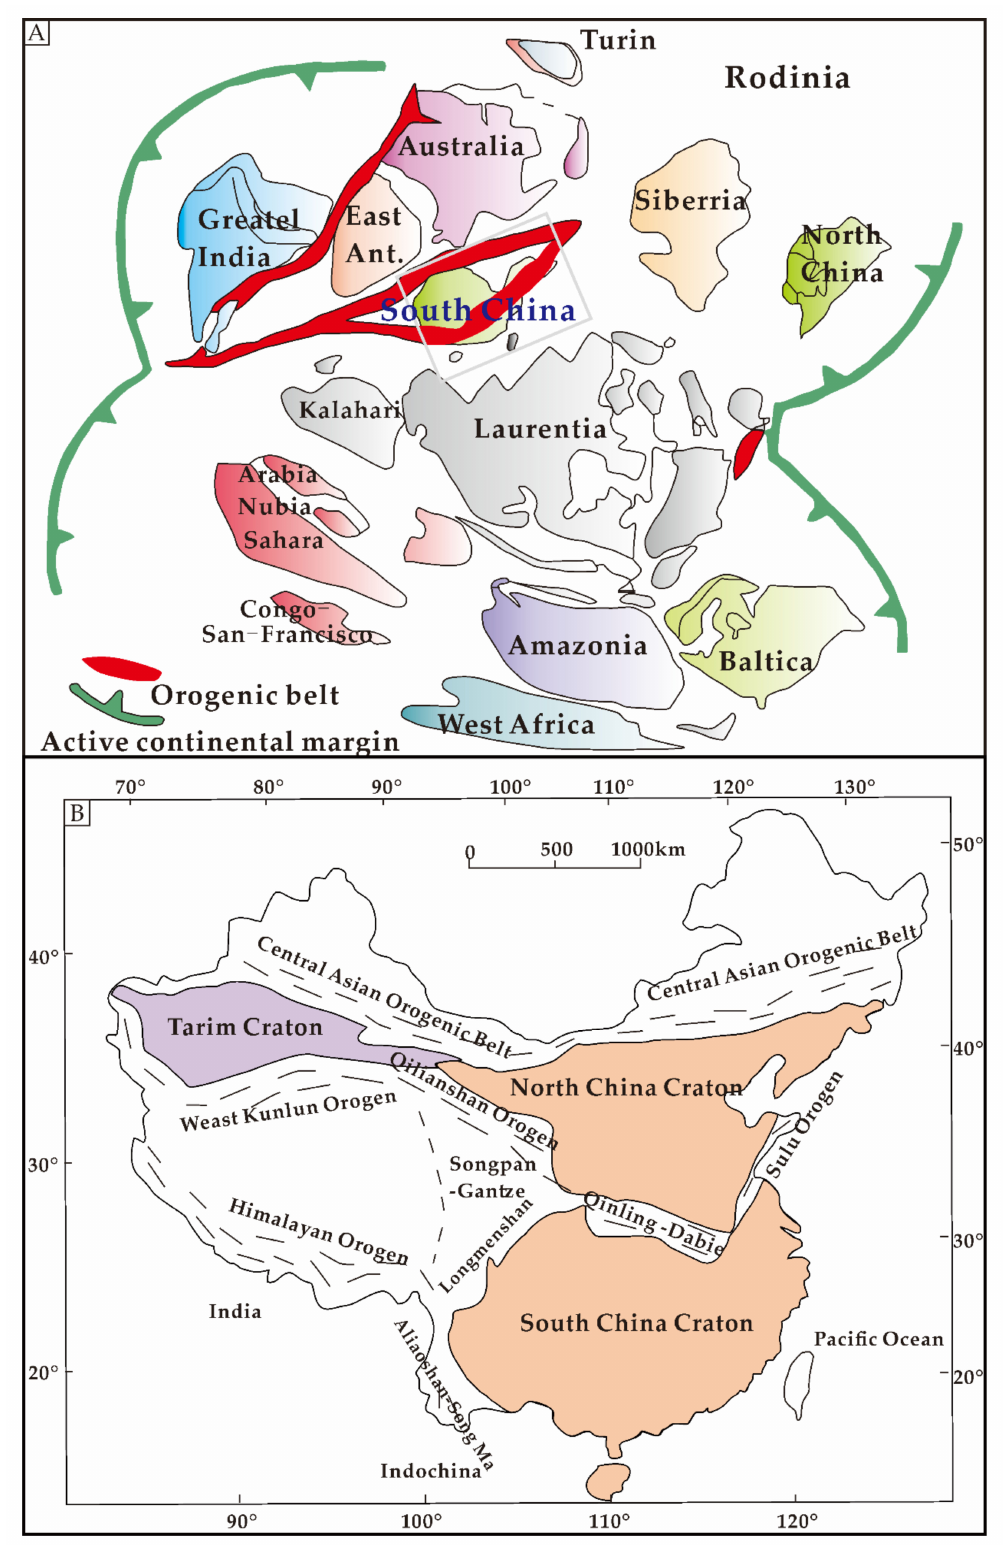
Figure 1. ( A ) Paleogeographic Map of Rodinia (From Li et al. 2008 [35]); ( B ) Schematic tectonic Map of China (From Zhao et al. 2012